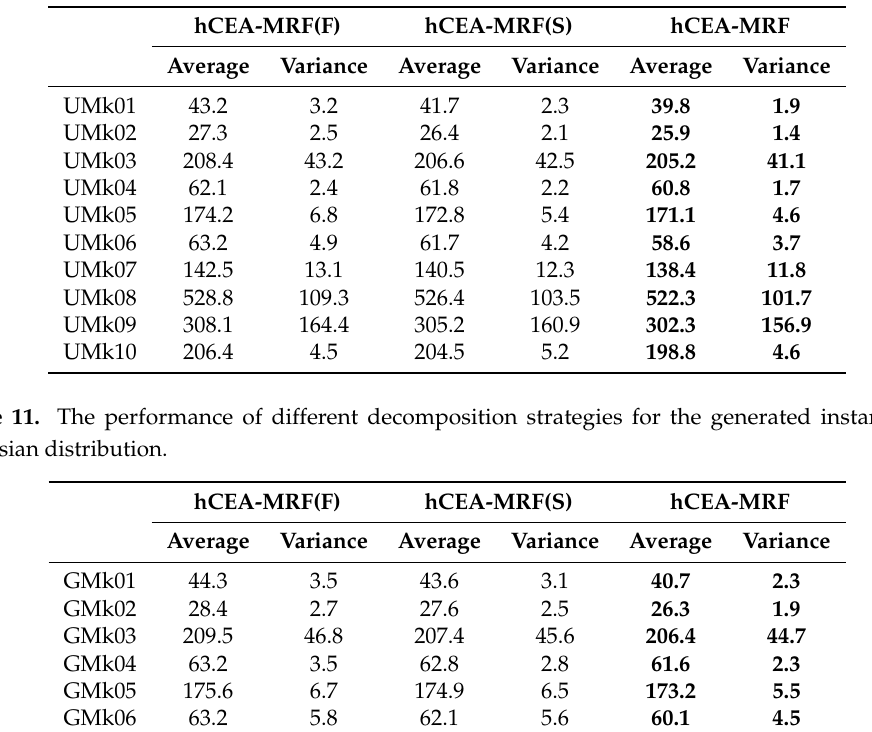
Table 10. The performance of different decomposition strategies for the generated instances by uniform distribution.